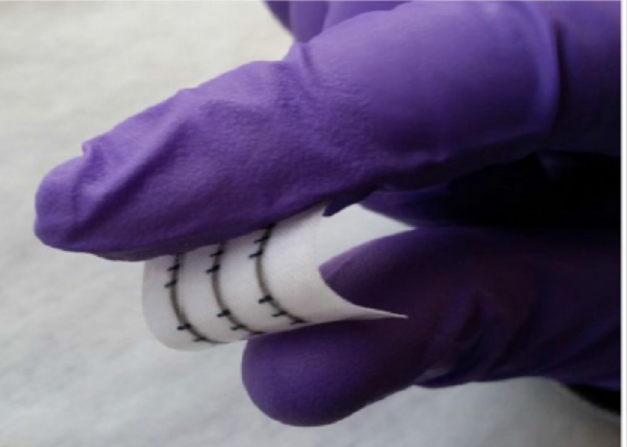
Figure 16. Graphene-based ink and an inkjet-printing process to print integrated circuits onto fabric [119].